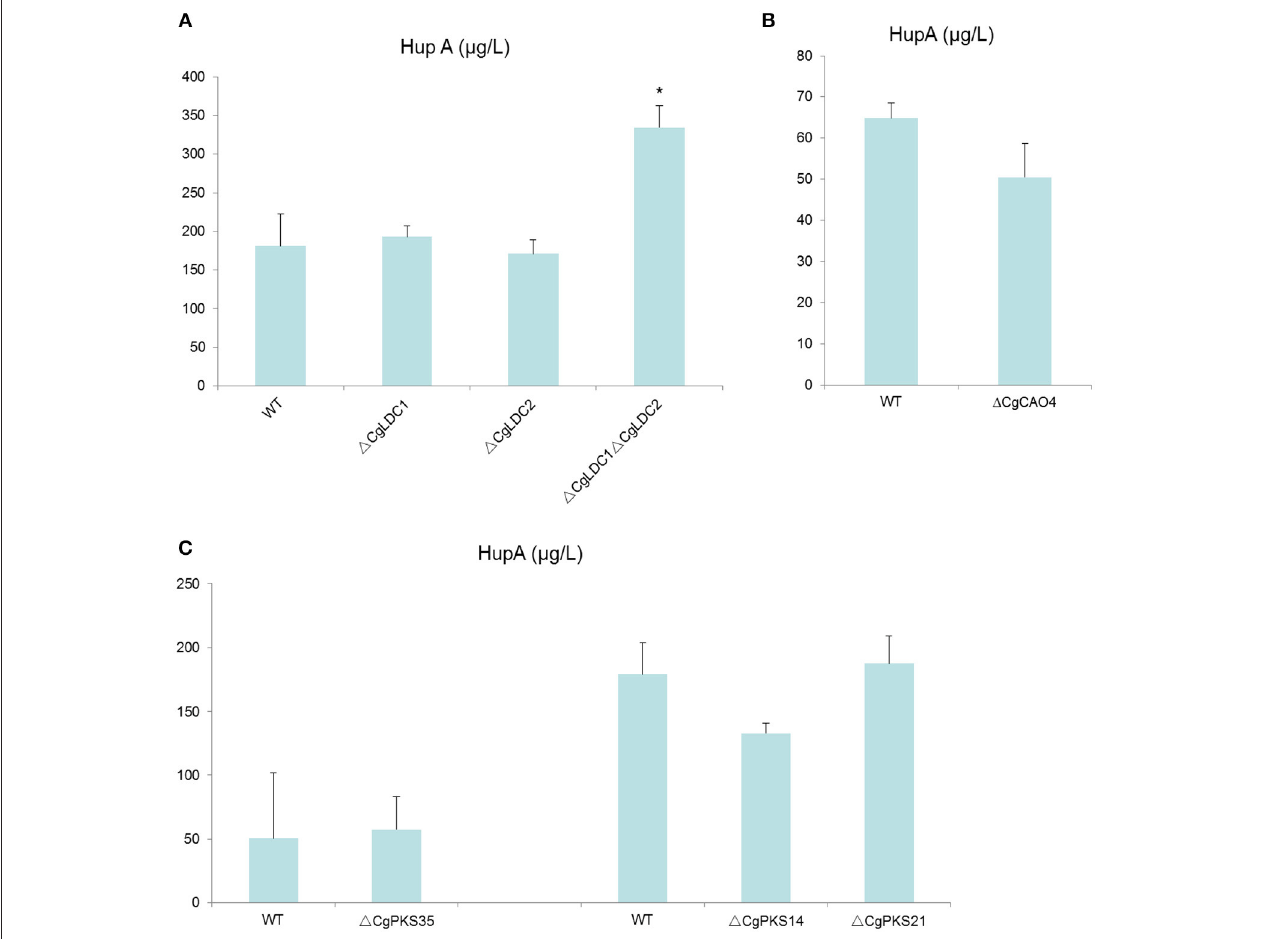
FIGURE 9 | Comparison of HupA production from culture extracts from wild type (WT) C. gloeosporioides Cg01 and LDC, CAO, and PKS gene knock out mutants ( A : LDC; B : CAO; C : PKS). The experiment was performed in triplicate. Mean values and standard deviations are given. Asterisks above the bars denote significant differences in the measurements of the indicated strains compared to the WT. * p <